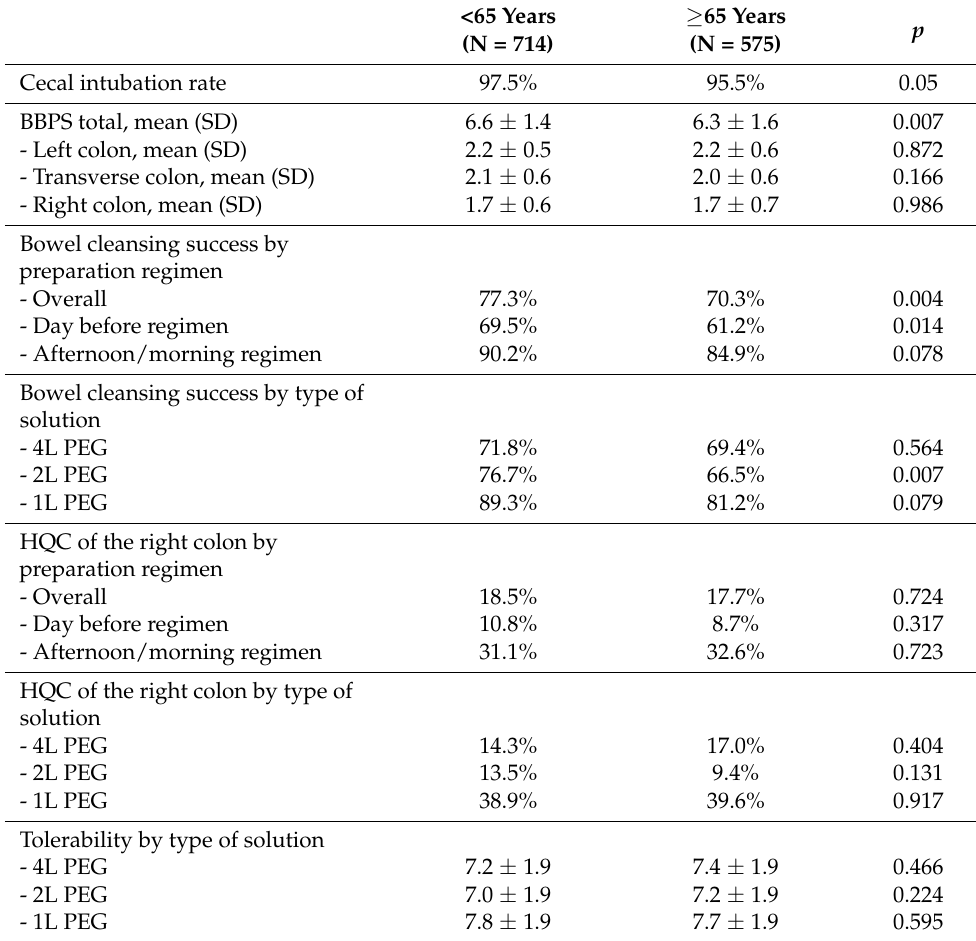
Table 2. Outcomes of bowel cleansing in younger and elderly